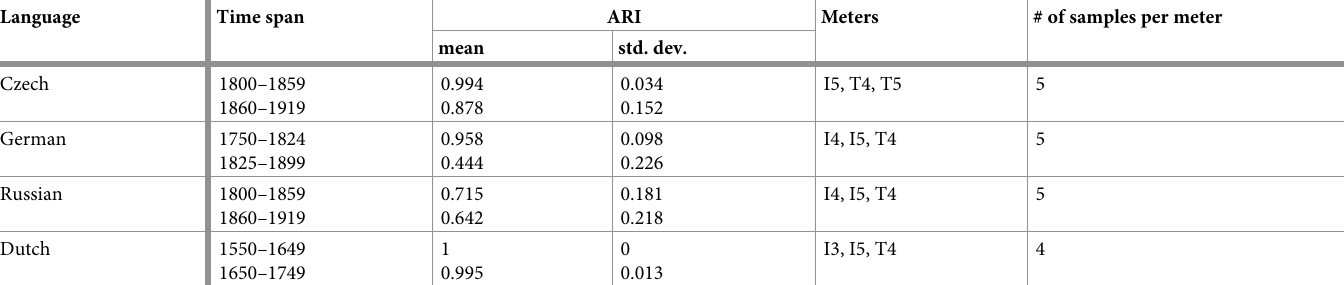
Table 2. Adjusted Rand Index of k -means clustering in different periods (random 100-poem samples). 10,000 iterations.